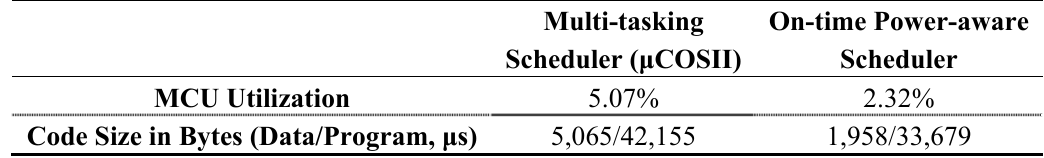
Table 4. Comparison of system resources